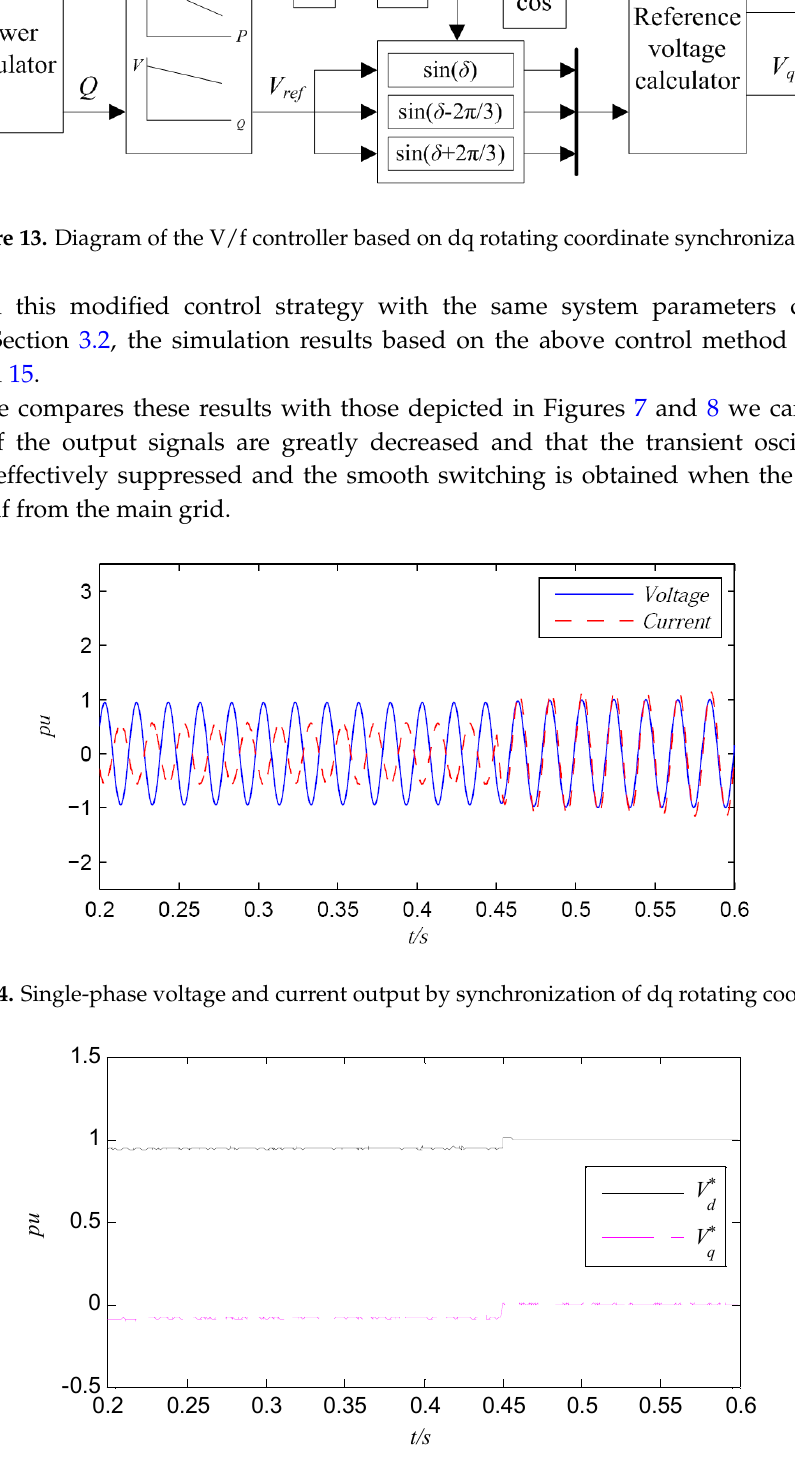
Figure 15. The output of controller during the operation mode switching to isolated mode.